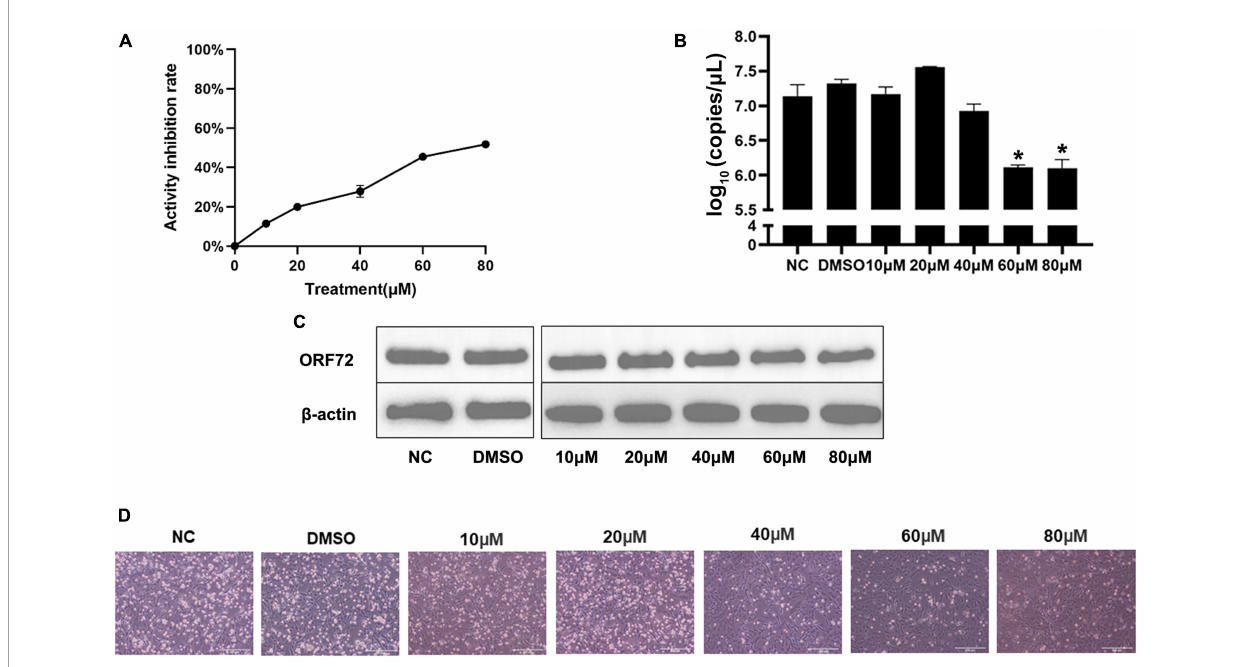
FIGURE9 Hydroxyurea inhibited CyHV-2 replication and protein expression. (A) Inhibitory effect of hydroxyurea on ribonucleotide reductase, and the dosage of both recombinant proteins is 10 µ g. (B) Changes of CyHV-2 copy number in virus infected (MOI = 1) cells treated with 0, 10, 20, 40, 60, and 80 µ M hydroxyurea. (C) The nucleocapsid protein expression of CyHV-2 ORF72 under 0, 10, 20, 40, 60, and 80 µ M hydroxyurea treatment. (D) Status of CyHV-2 infected (MOI = 1) cells under 0, 10, 20, 40, 60, and 80 µ M hydroxyurea treatment. Mean ± SEM shows representative data sets from three independent experiments, * P < 0.05 vs. NC